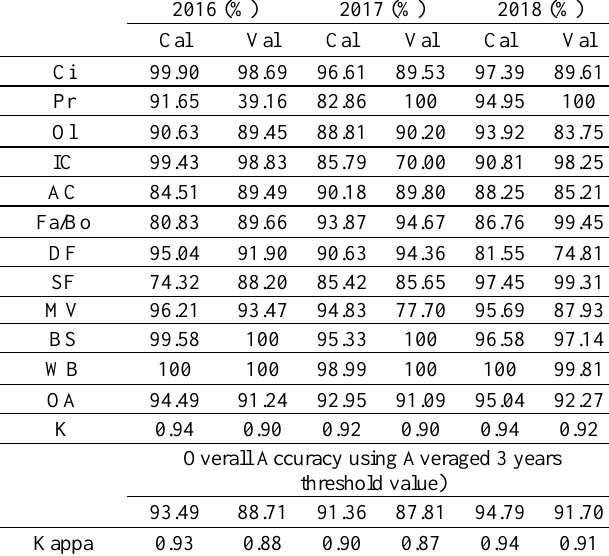
Table 5. Percent correct of all the classes using calibration (Cal) and validation (Val) samples as ground reference data for evaluating classifications.